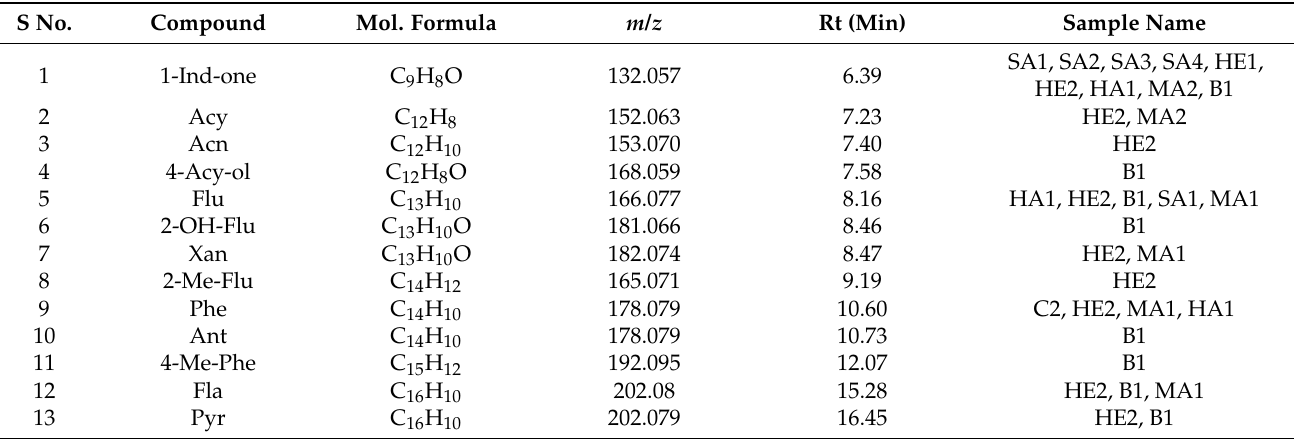
Table 4. List of tentatively identified substances (PAH) at a confidence level of 2a (match with